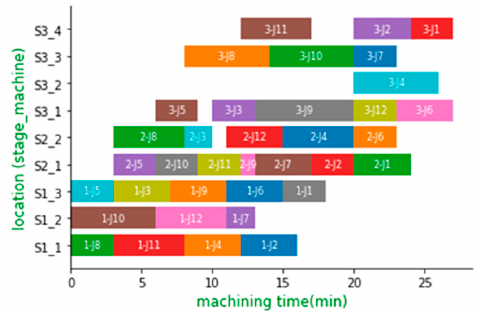
Figure 4. Gantt chart of one of the optimal scheduling of workpieces.